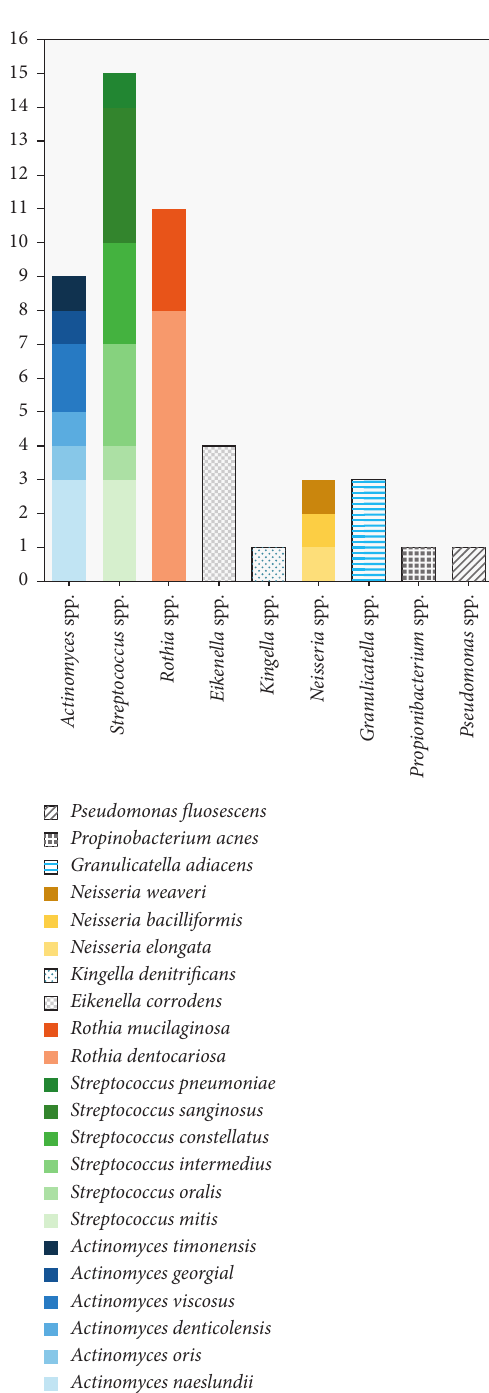
Figure 1: Frequency of identified samples among patients with chronic severe